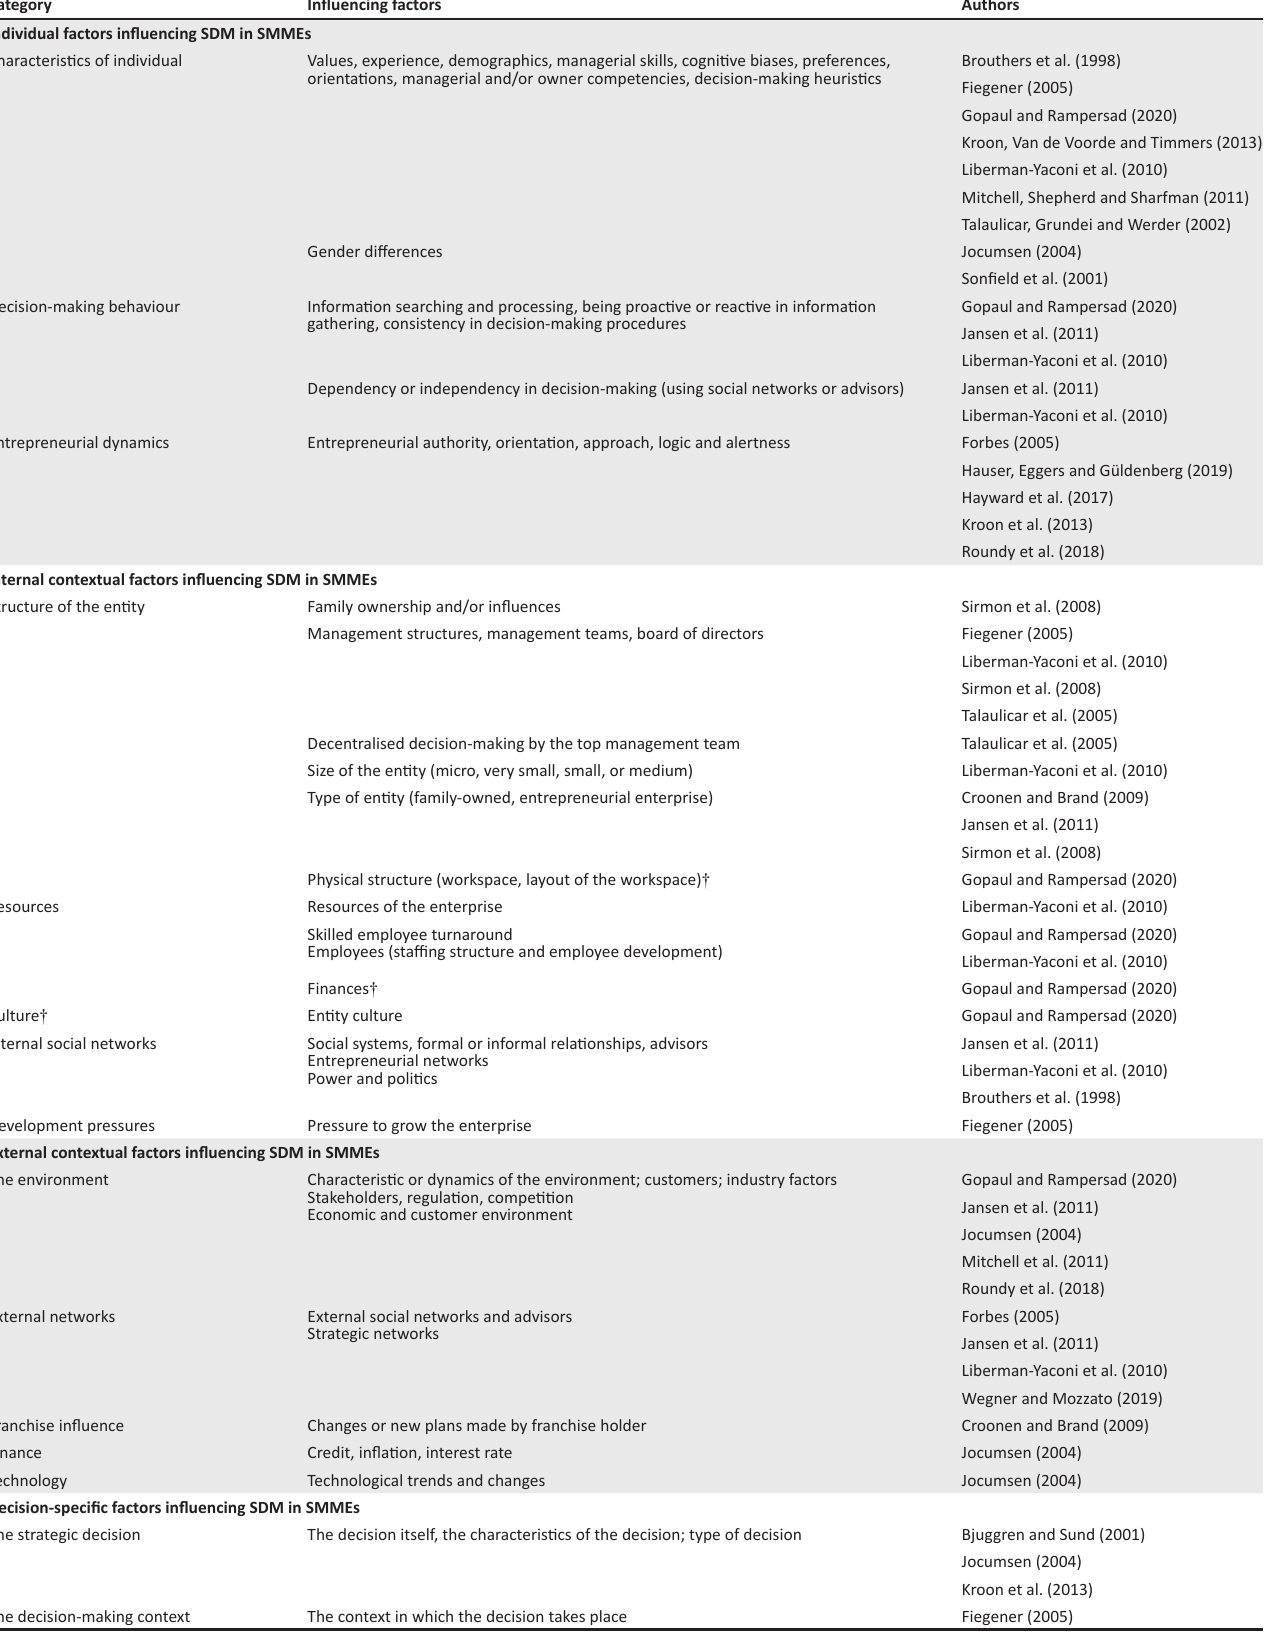
TABLE 2: Influencing factors relevant to strategic decision-making specific in small-, medium- and micro-enterprises.